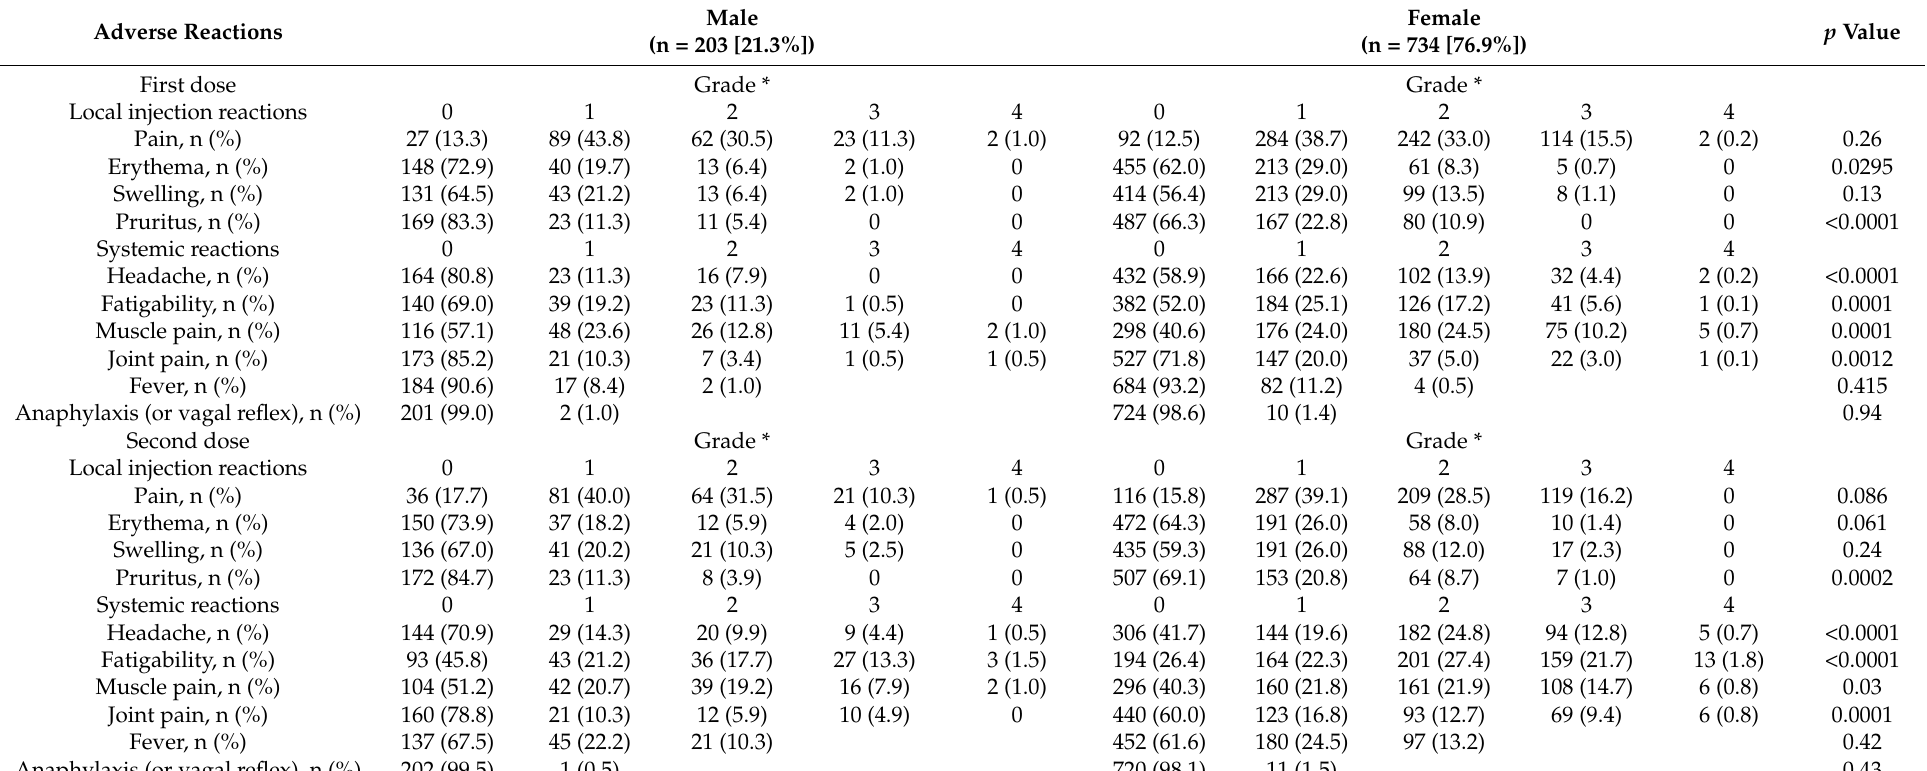
Table 2. Comparison of grades of each adverse reaction between male and female